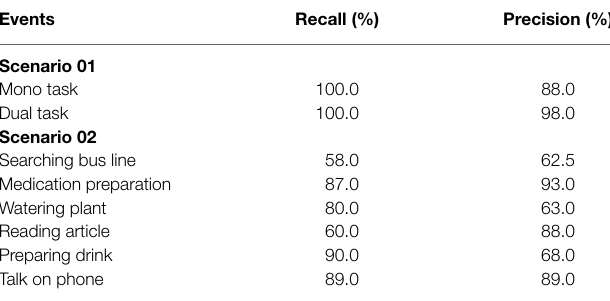
TABLE 6 | Activity/event detection performance .